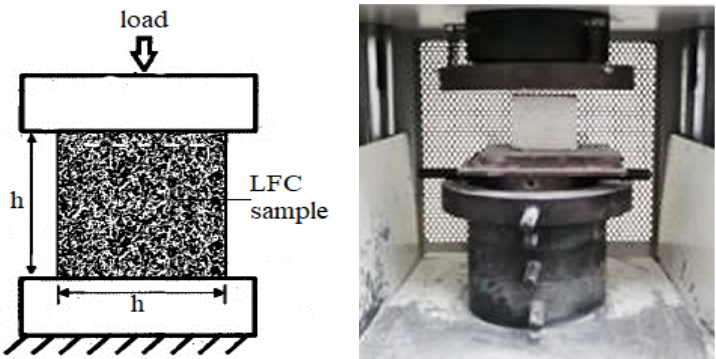
Figure 4. Setup for compression test.